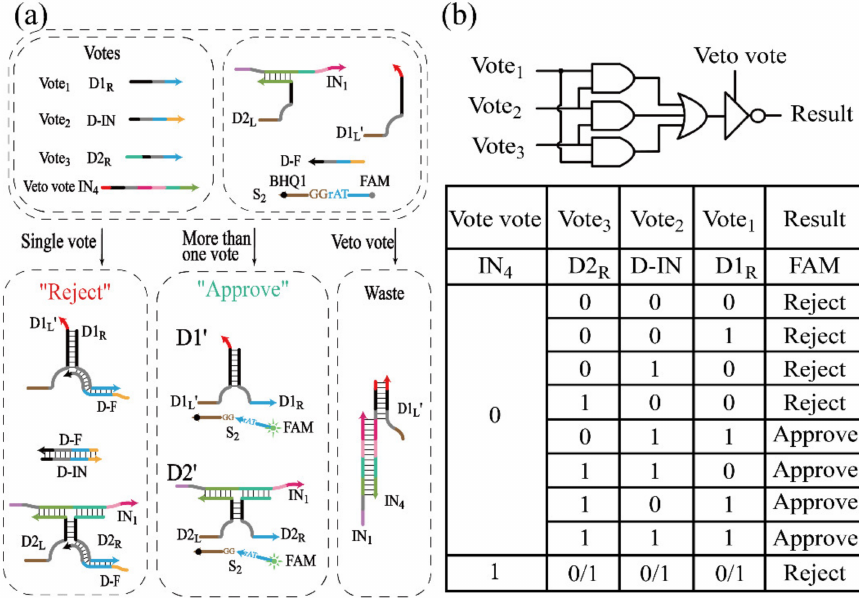
Figure 7. ( a ) Schematic diagram of the DNA voter with the one-vote veto function. ( b ) Truth table and logical operations of the DNA